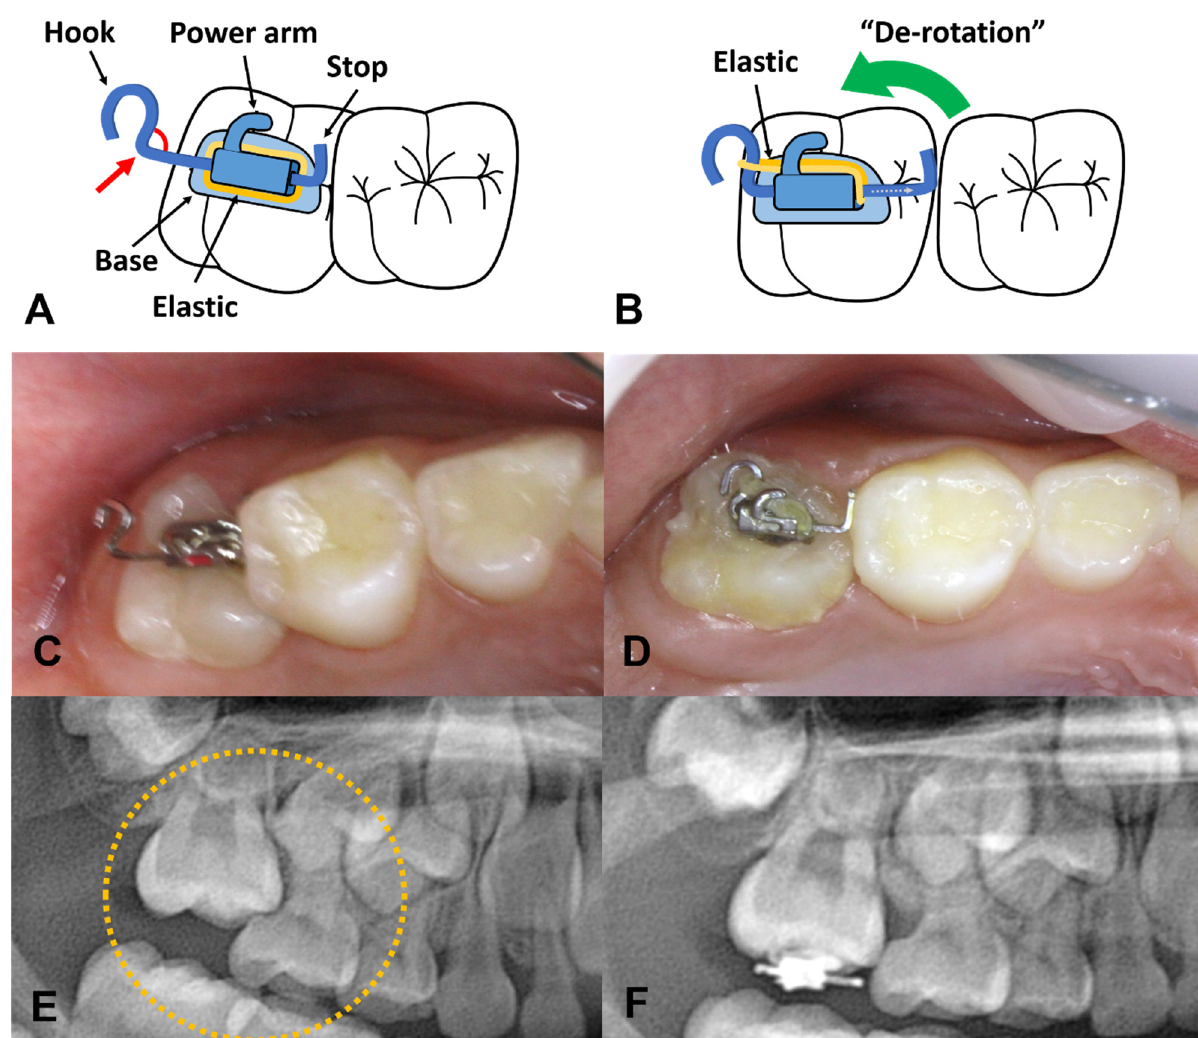
Figure 1. Design of the piston-elastic and its action. ( A , C , E ) Piston-elastic is bonded on occlusal surface of locked molar with the hook located on distal side. The elastic is placed such as in the figure. In order to prevent the slipping off of an elastic, the angle between the straight part of the wire and the hook should be less than 90 degrees (red arrow). ( B , D , F ) By the mechanism of piston-elastic, the ectopic molar gradually moves toward the distal side.